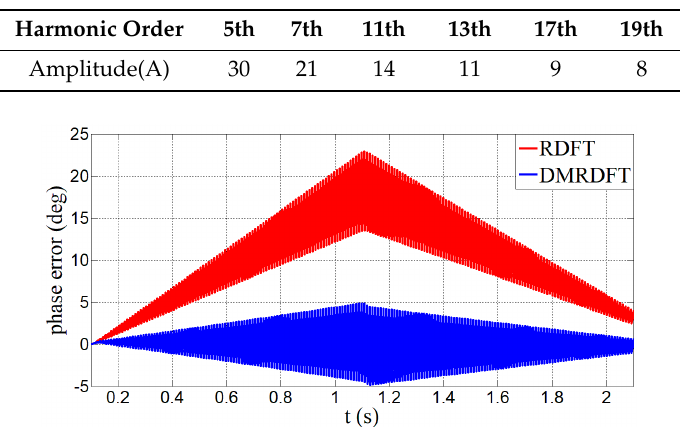
Table 1. Constitution of the harmonic current.